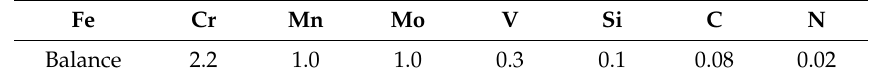
Table 2. Chemical composition in wt.% of the investigated 2.25Cr-1Mo-0.25V SAW weld